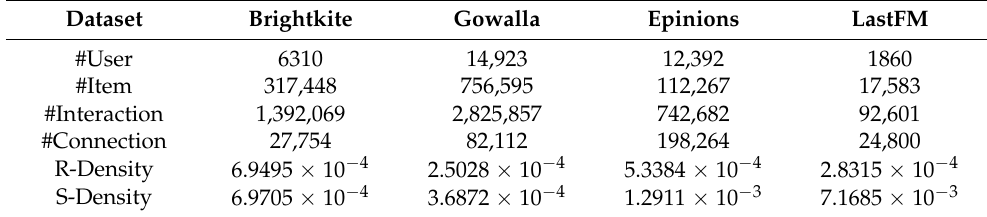
Table 1. Statistical details of four